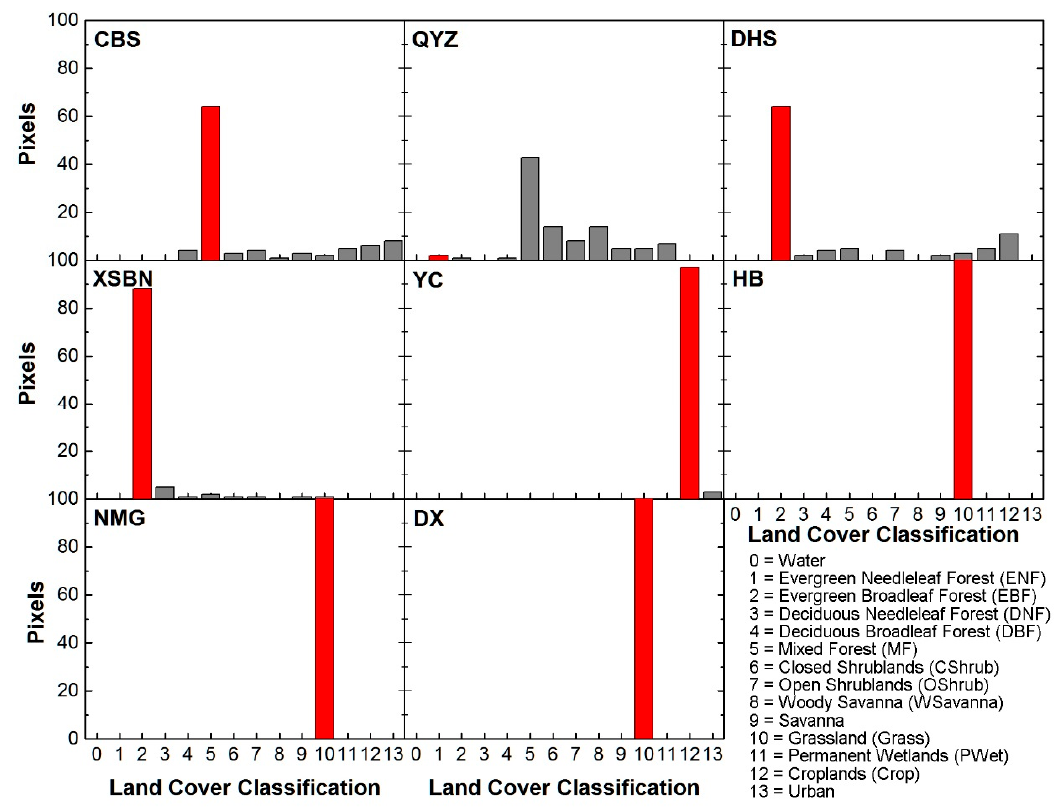
Figure 11. University of Maryland (UMD) land cover classification (MCD12Q1 Collection 5.1, Land Cover Classification Type 2) for the eight sites. The red columns indicate the actual land cover at each site.